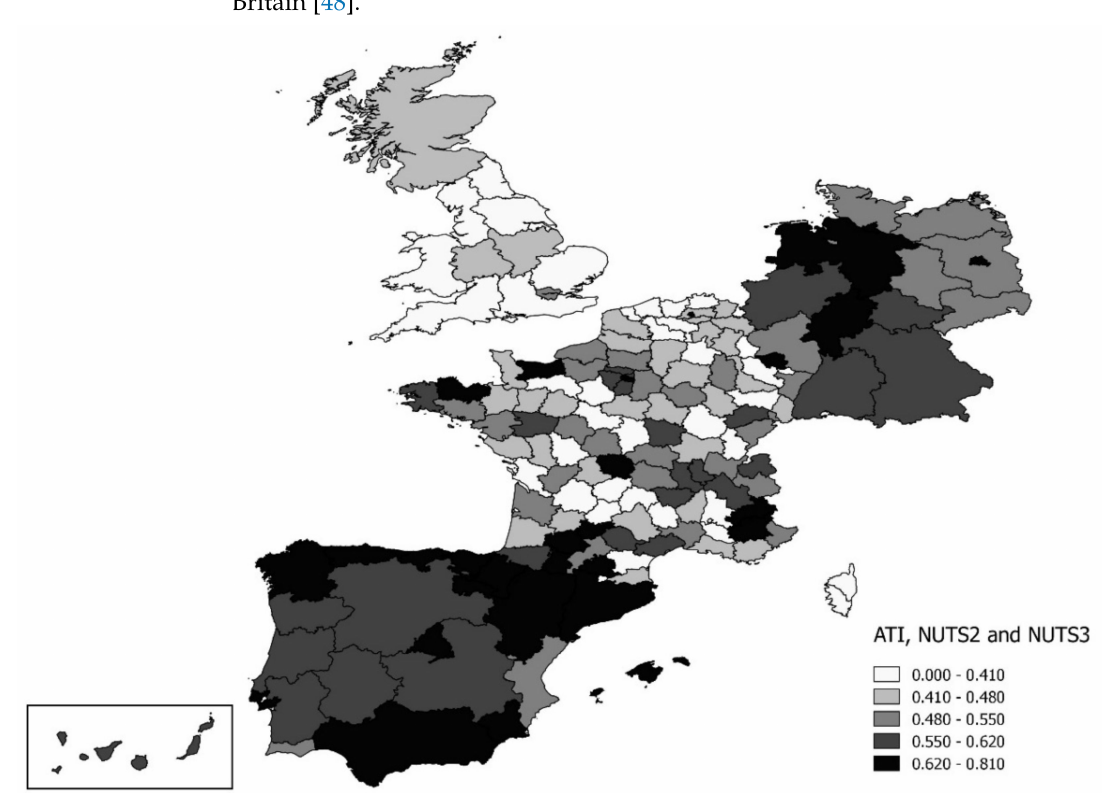
Figure 1. ATI at the territorial level—our own elaboration.